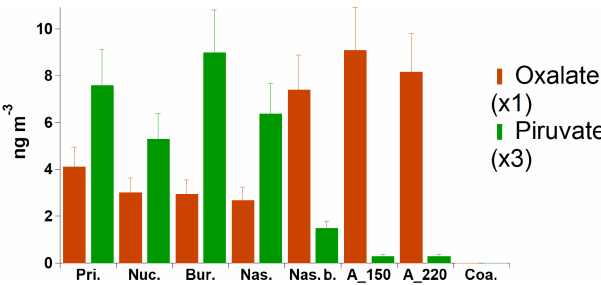
Figure 8. Average daily concentrations of selected chemical tracers for each aerosol category (GRU only).